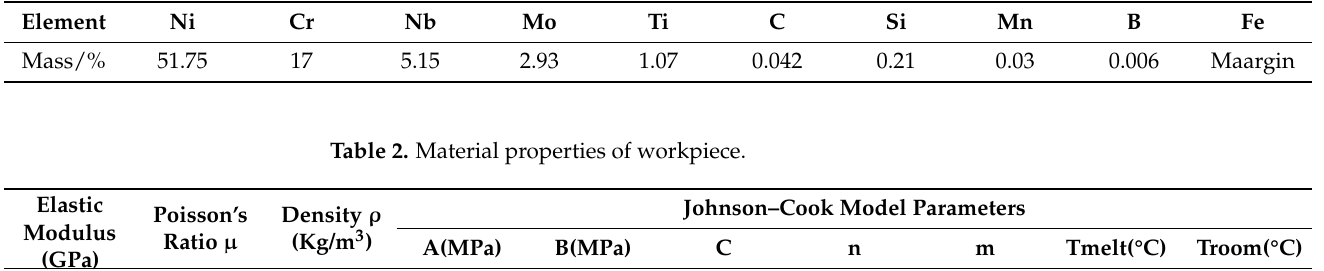
Table 1. Chemical composition of nickel-base superalloy GH4169.